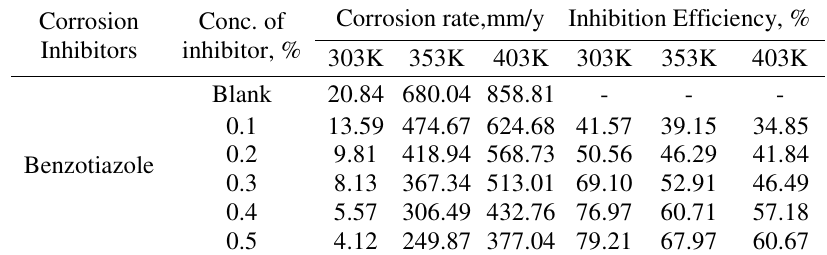
Table 1. Corrosion inhibition behaviour of mild steel in 1N citric acid solution in absence and presence benzotriazole by weight loss